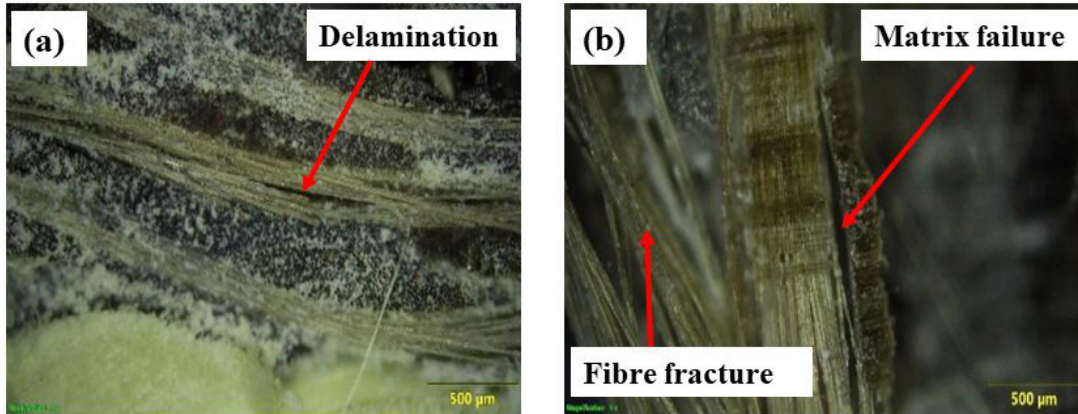
Figure 13. Optical microscope images of fractured (a) (0 1A /0 3B /0 1A ) (b) (45 1A /0 3B /45 1A ) impact